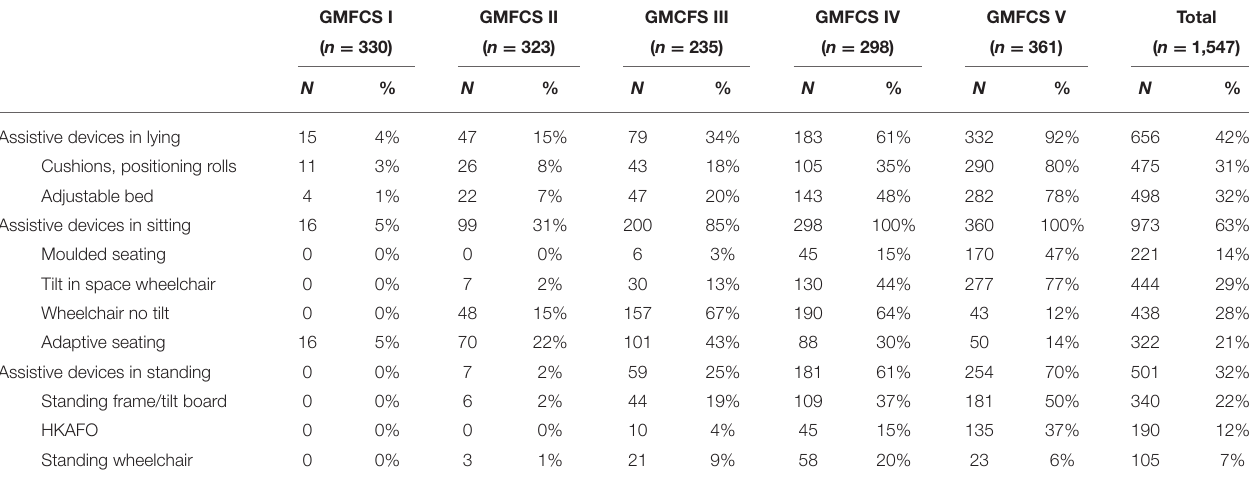
TABLE 2 | Assistive devices used in lying, sitting and standing by adults at GMFCS I to